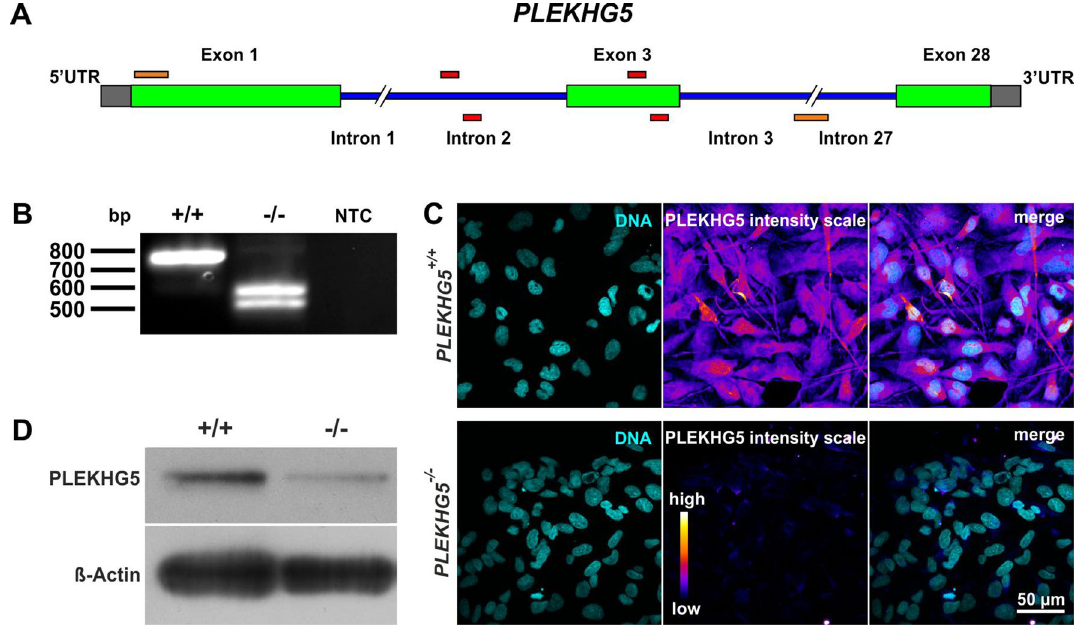
Figure 1. Generation and validation of the PLEKHG5 knockout in human U251-MG cells. ( A ) Graphical representation of the PLEKHG5 gene, including the placed sgRNAs in red and the related binding sites of the genomic primer pair in orange, spanning over the region from exon 1 to intron 4. ( B ) Genomic PCR products from clonally grown human PLEKHG5 +/+ and PLEKHG5 −/− cells. PLEKHG5 knockout shows bands around 500–600 bp in contrast to the wildtype at 750 bp. ( C ) Immunocytochemistry of PLEKHG5 +/+ and PLEKHG5 −/− cells revealed the presence of PLEKHG5 in wildtype cells, which was completely lost in PLEKHG5-deficient cells. ( D ) Western blotting of whole cell lysates from PLEKHG5 +/+ and PLEKHG5 −/− cells depicting the strong decrease of PLEKHG5 protein within the PLEKHG5 knockout compared to wildtype. β-Actin served as a loading